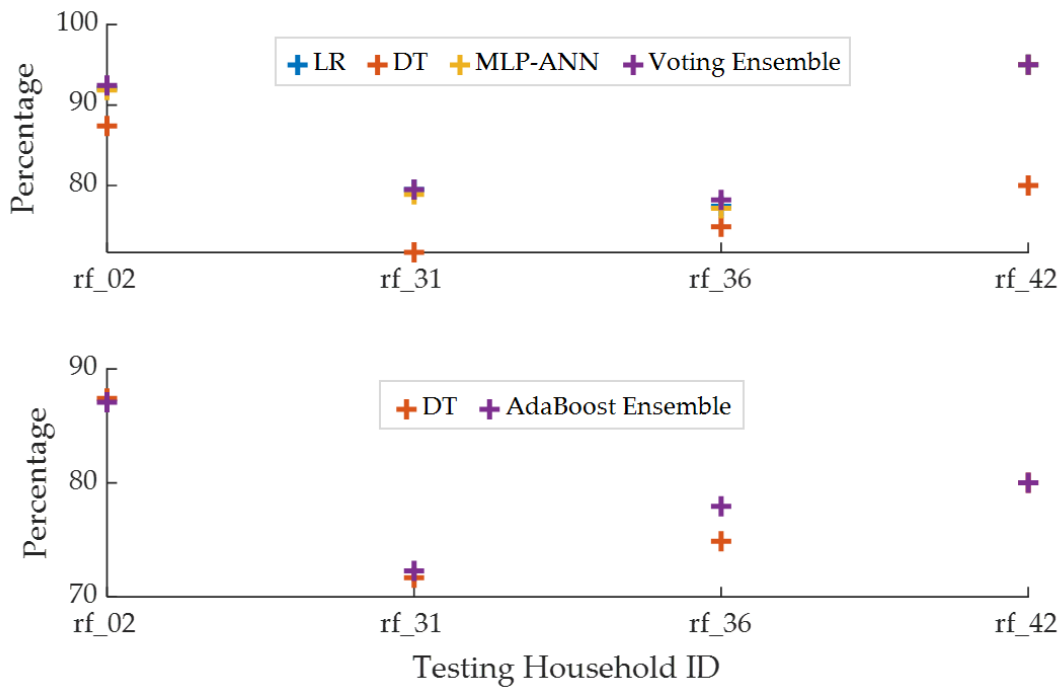
Figure 6. Household-level performance comparison.